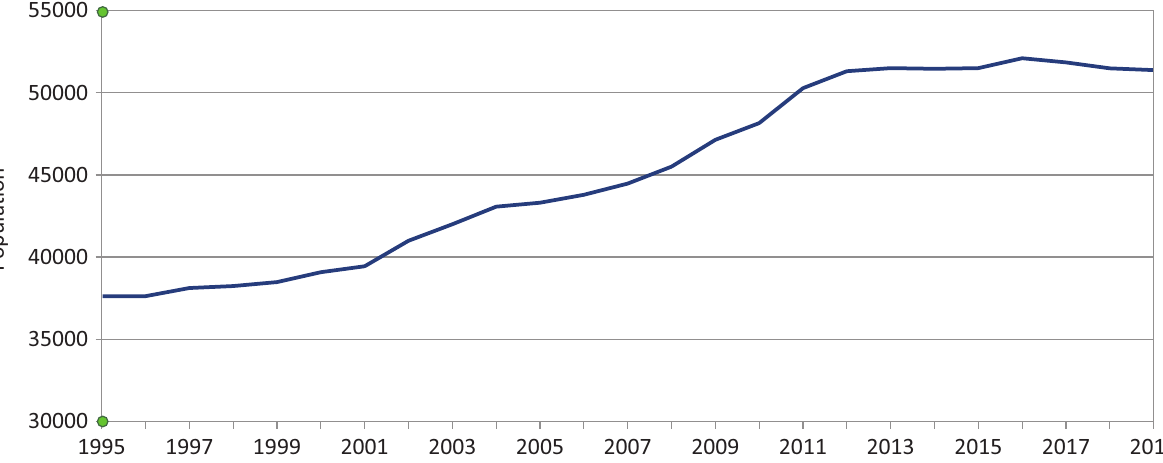
Figure 2. Evolution of population between 1995 and 2019 in Sint-Jans-Molenbeek. Source: Wijkmonitor Brussel (2019), processed by Sarah De